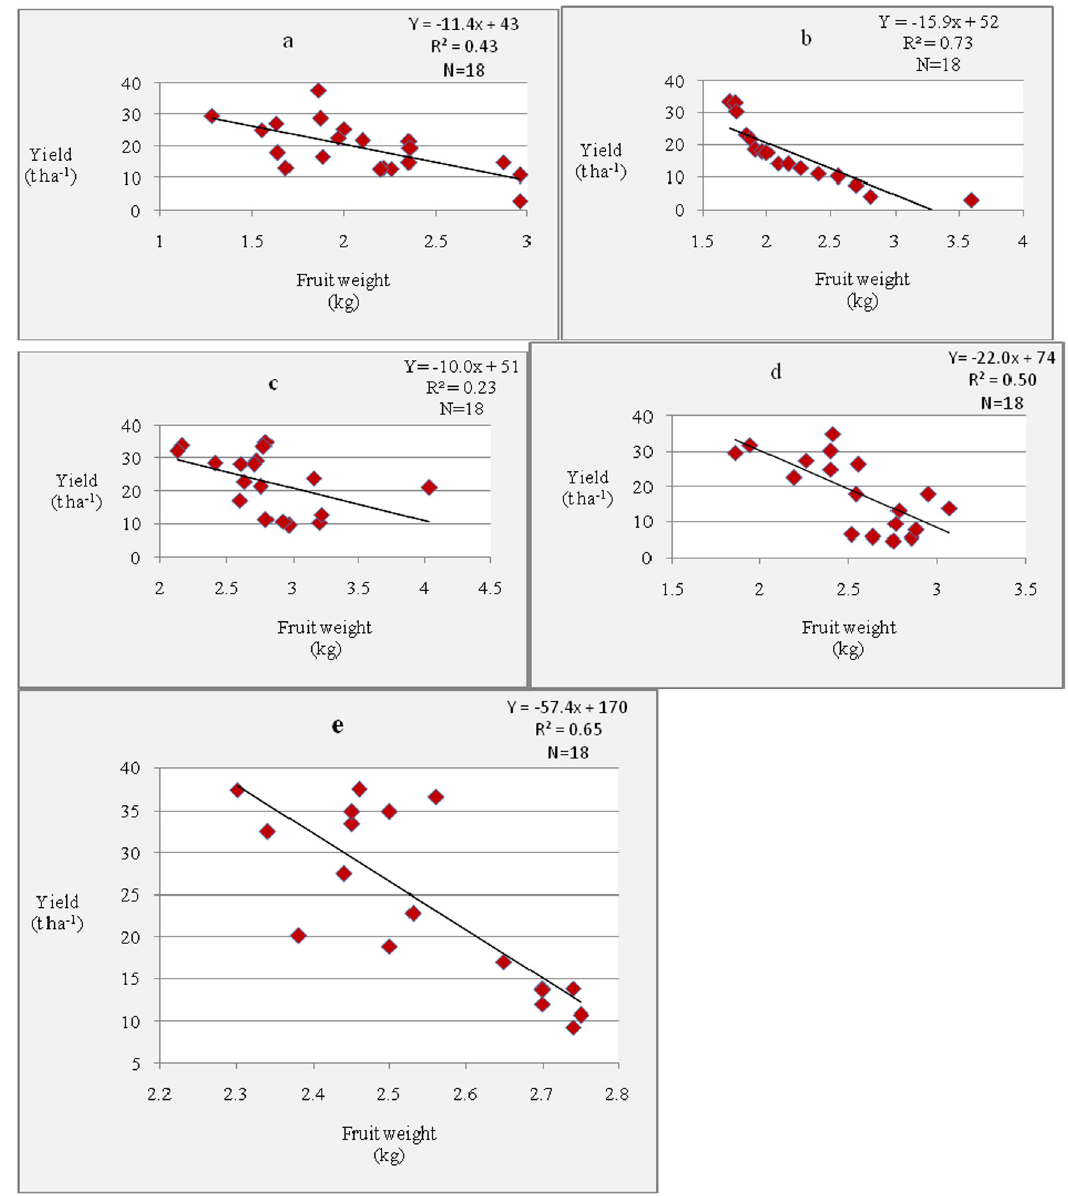
Figure 6: Relationship between fruit yield and weight of Sugar Baby within each plant density: ( a ) 24,690 ha − 1 , ( b ) 13,888 ha − 1 , ( c ) 8,888 ha − 1 , ( d ) 6,172 ha − 1 , and ( e ) 4,535 ha − 1